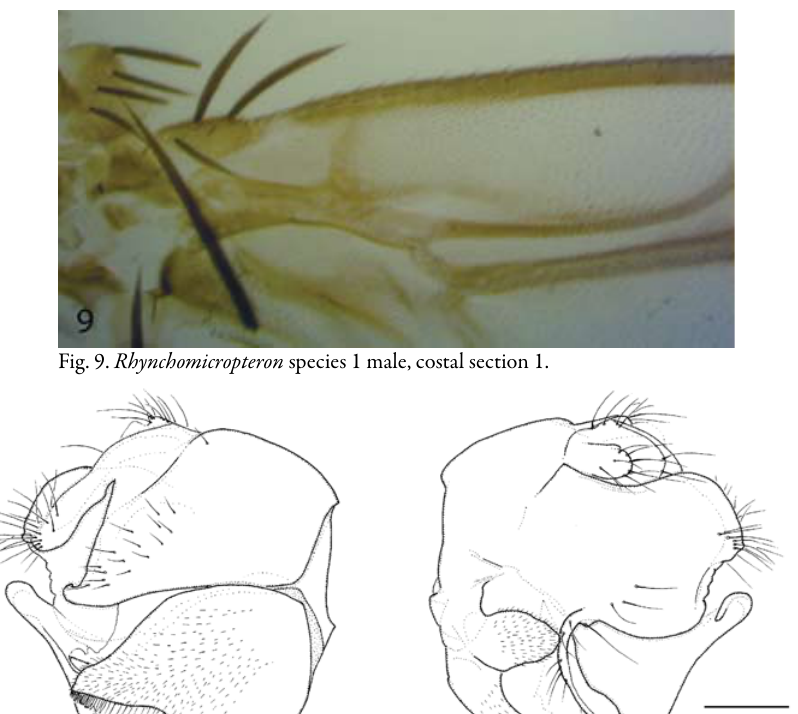
Fig. 11. Rhynchomicropteron species 1 male, right face of hypopygium.